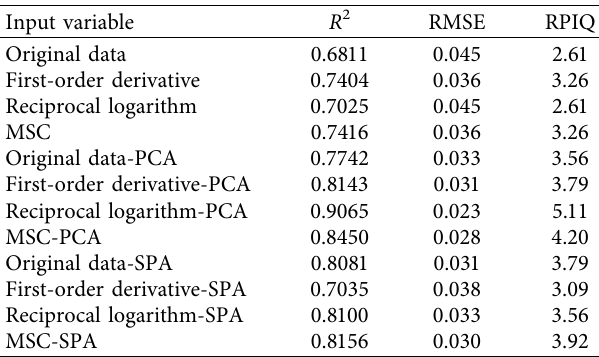
Figure 7: Prediction of PCA-GRNN model: (a) original data; (b) frst-order derivative; (c) reciprocal logarithm; and (d) MSC. Te black and red lines show the 1:1 relationship and the model trend. Te original data-PCA-GRNN model falls within the largest number of points within the 95% confdence band. Table 6: Assessment of the CNN prediction